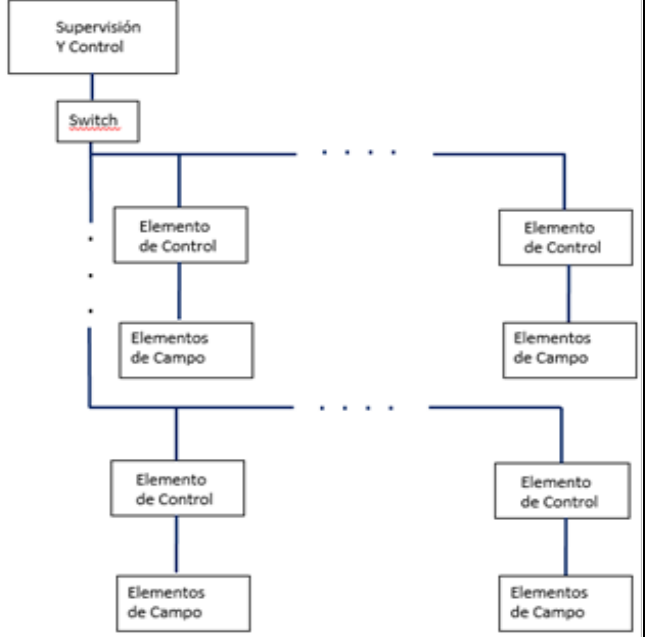
Figura 2: Diagrama en bloques de Red distribuida. Fuente: Los autores, (2018).